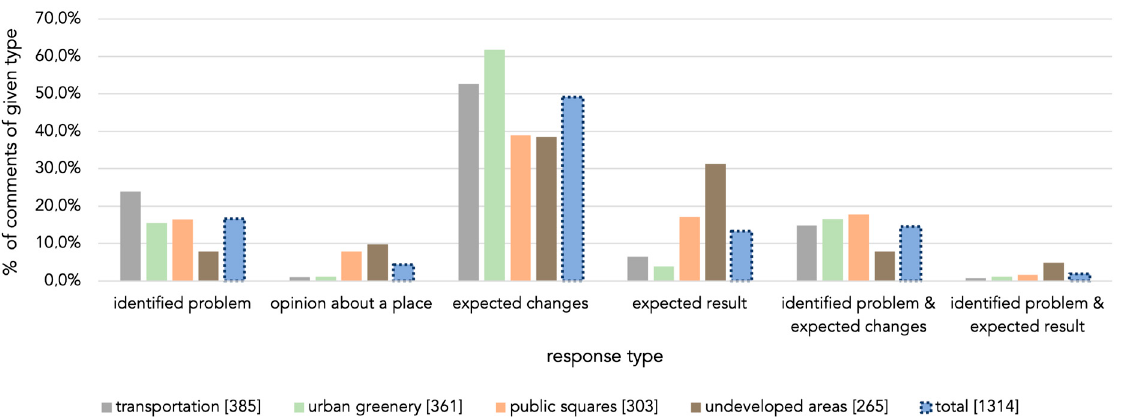
Figure 2. Structure of the types of respondents’ comments (responses) on expected changes according to different land use. The number of indicated places and accompanying comments are shown in the brackets. Each respondent could indicate a maximum of three places in each land use cate- gory.